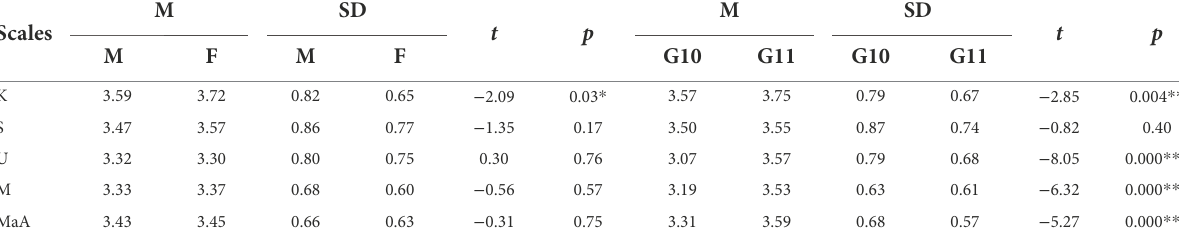
TABLE 2 The results of gender and grade differences in learner autonomy.